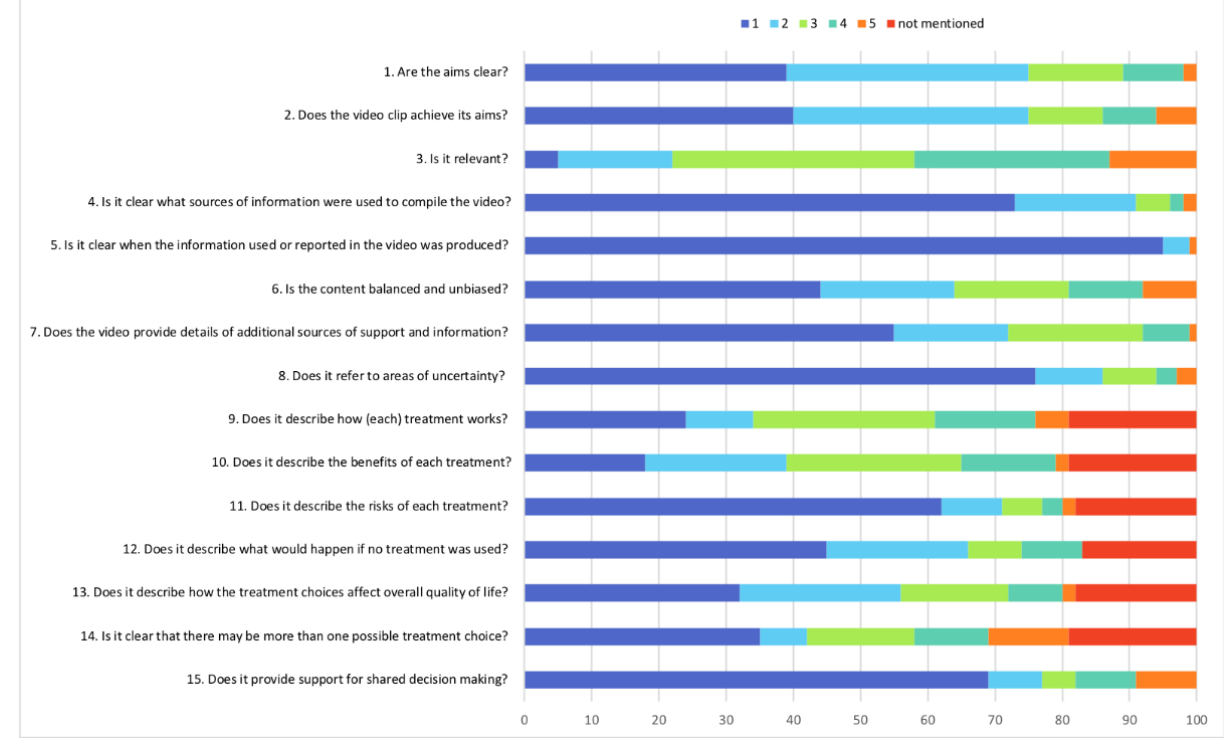
Figure 2. Detailed analysis of the DISCERN questionnaire (questions 1-15) used to rate the identified videos (n=100). The instrument uses a 5-point scale ranging from no to yes, where 1 means “no” (the quality criterion has not been fulfilled at all), 2-4 means “partially” (the quality criterion has been fulfilled to some extent), and 5 means “yes” (the quality criterion has been completely